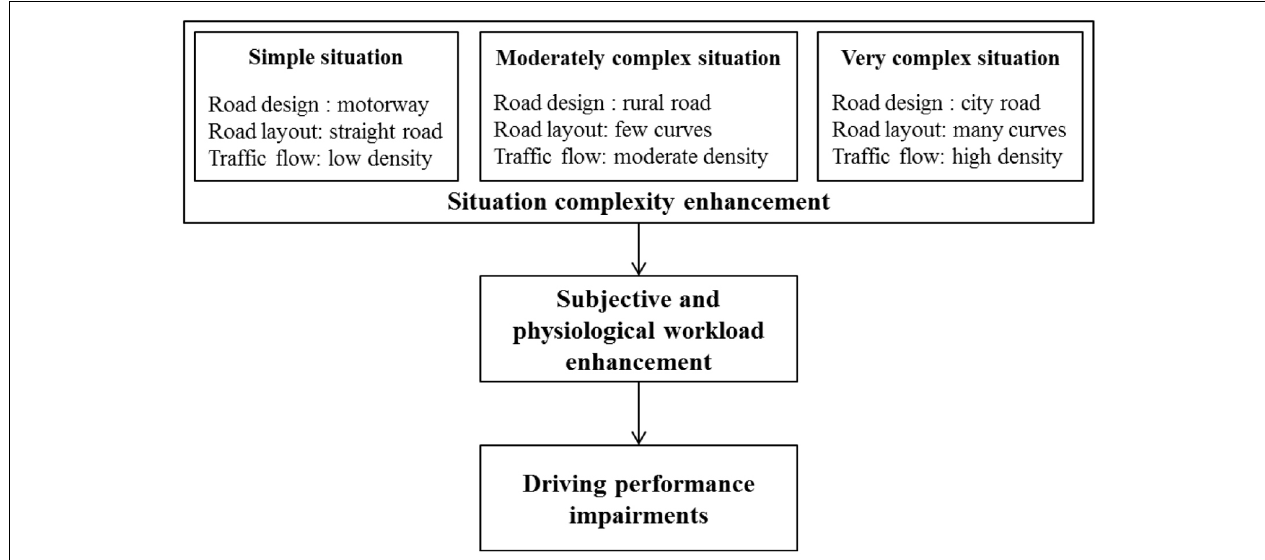
FIGURE 1 | Predictors of mental workload and performance